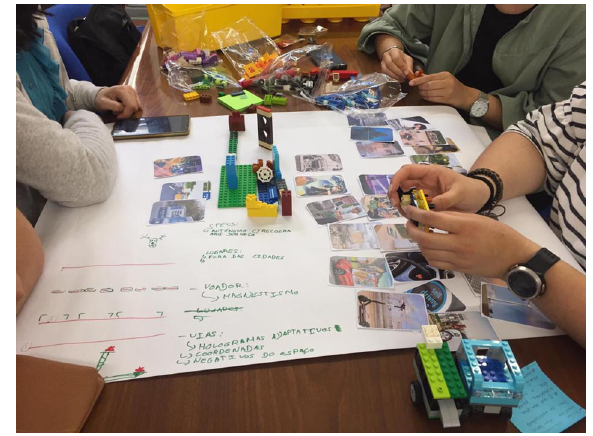
Fig. 2 Photo of material deliberation. Photo of material co-creation and deliberation through ® Lego and ‘ CAV Cards ’ at a Futures Making Atelier